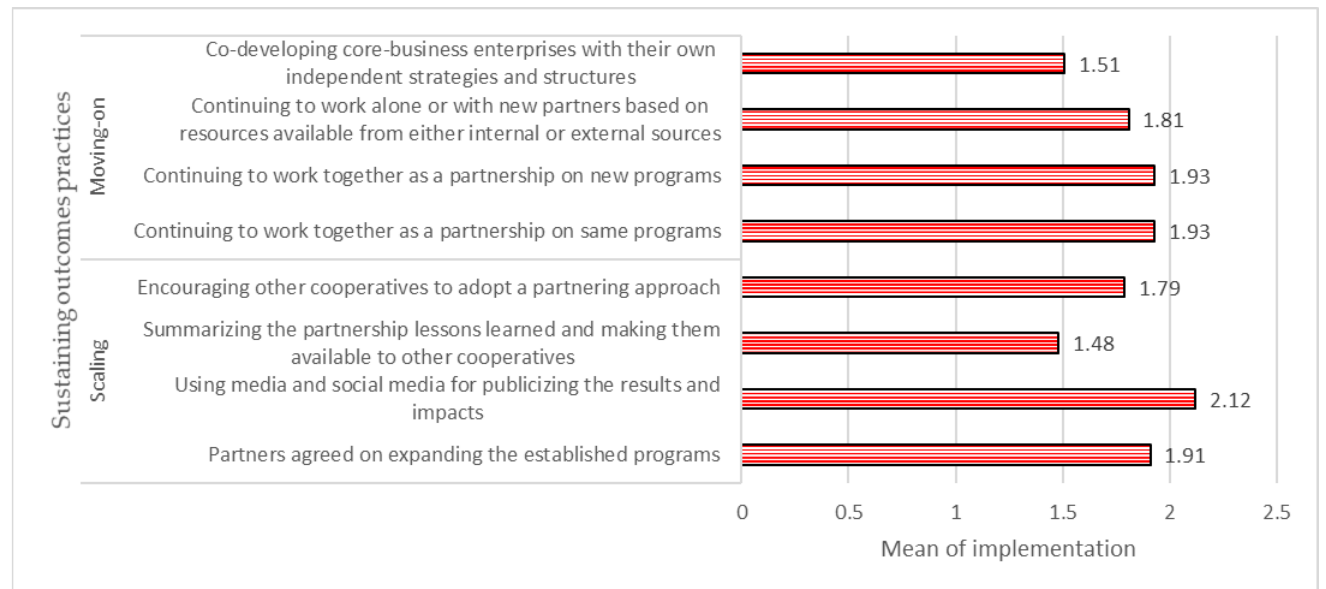
Figure 6. Sustaining outcomes practices applied in the partnerships.